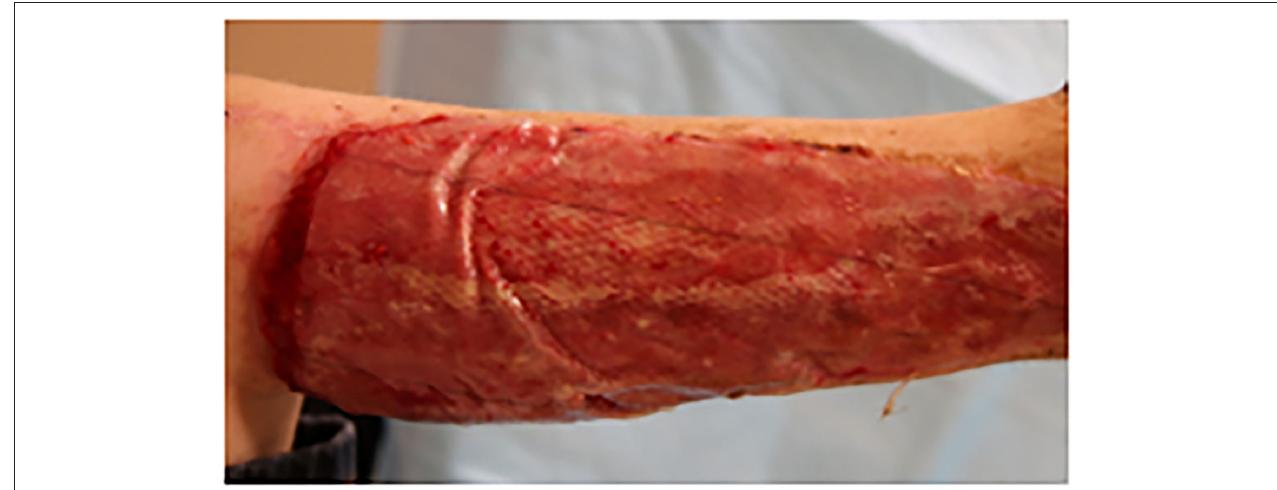
FIGURE 5 | Collagen (type 1) dressing (Integra ® , Plainsboro, NJ) for lower extremity wound